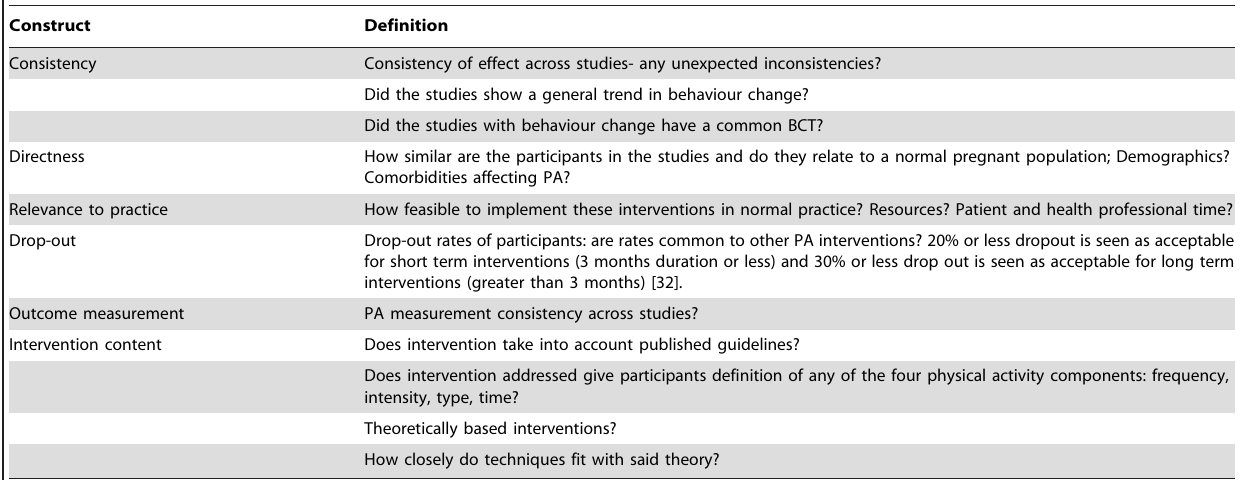
Table 1. Definitions for quality assessment 1 (external